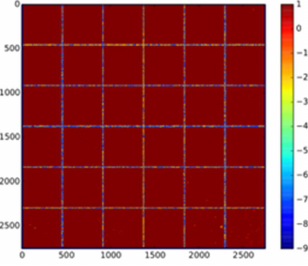
Figure 8 : Medicis validity flags corresponding to the disparity maps presented in Figure 7. There are 2.14% of -2 invalid pixels that are mainly concentrated in the inter-blocks areas (-2 corresponding to the “exploration area edge” validity flag).